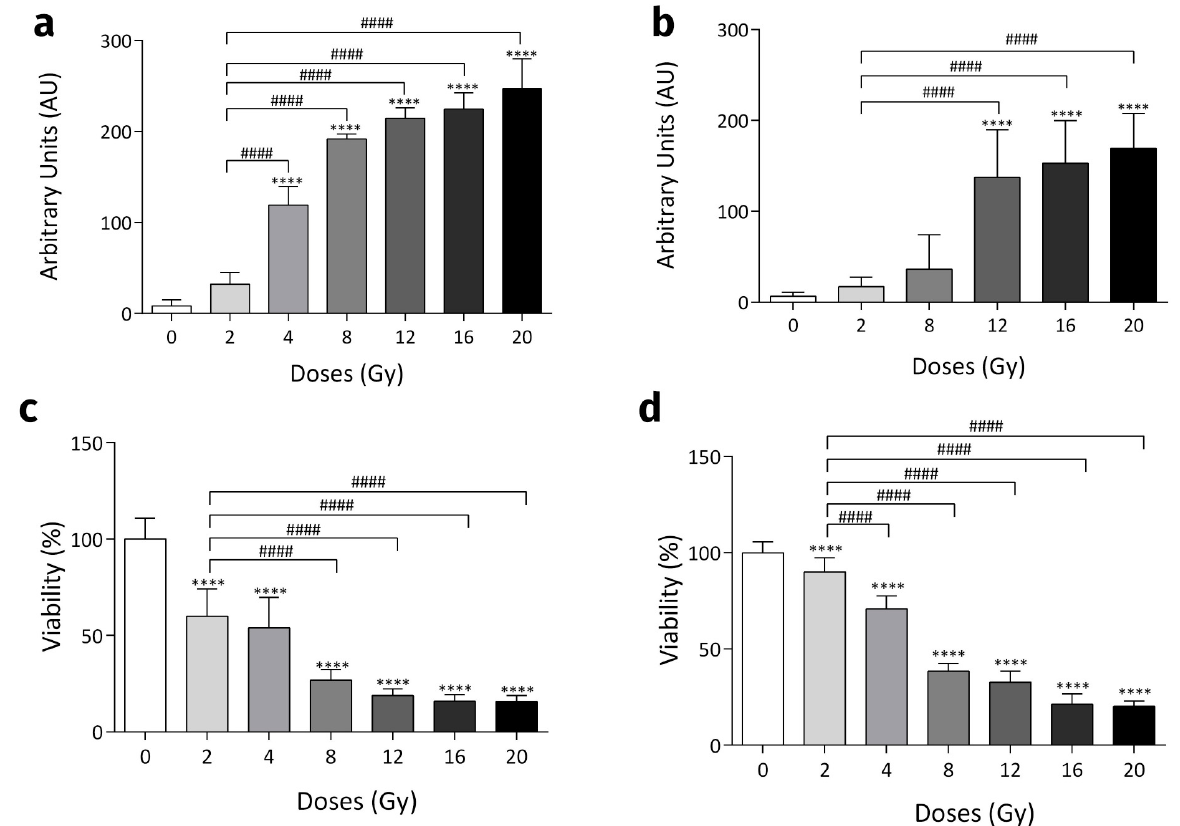
Figure 2. Genomic damage, repair and cell viability. Upper panel: Radiation-induced genotoxic effect evaluated in the A549 cell line just after irradiation (Panel a) and 3 h post irradiation (Panel b). Results were plotted as damage index vs Gy dose irradiation and expressed as mean ± SD. Lower panel: Percentage of viable A549 cells after irradiation with different Gy doses. Cell viability was measured by integrity of the plasma membrane (Panel c) and mitochondrial activity (Panel d). Results are expressed as mean ± SD. One-way ANOVA and post-hoc Tukey’s test, **** p < 0.0001 versus untreated control cells and #### p < 0.0001 versus cells treated with 2